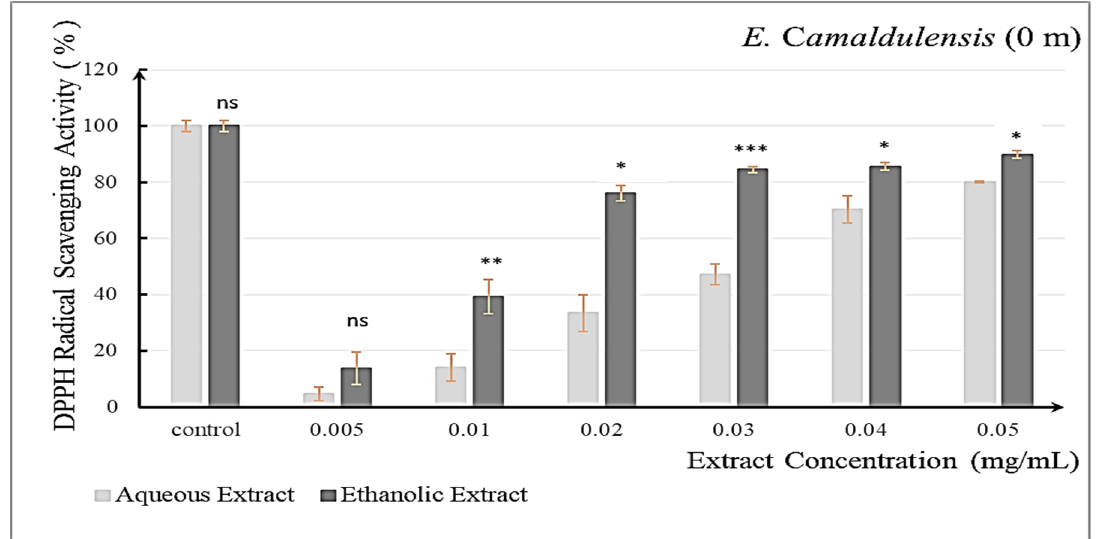
Figure 2. Radical scavenging activity of the ethanolic and aqueous extracts of E. camaldulensis (0 m). Peak values are represented as mean +/ − SD. Statistical analysis: Unpaired t test or Mann–Whitney test. * p < 0.05;** p <0.01, *** p <0.001 **** and ns refers to non-significant results.